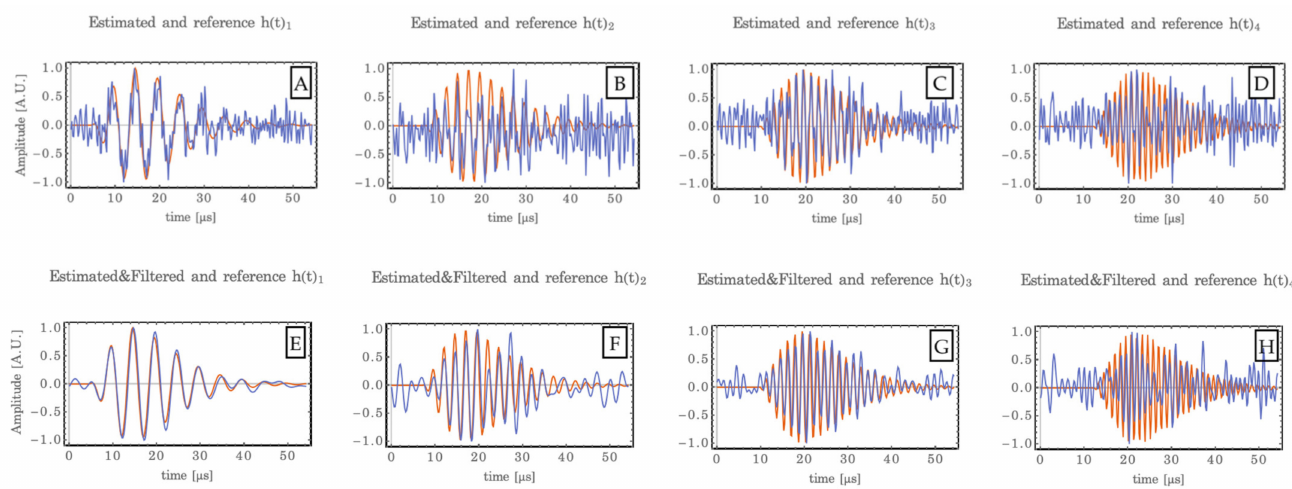
Figure 6. Estimated h k ( t ) kernels in the case SNR 1 = 5 [dB] (blue lines) and reference kernels (red lines). Plots ( A – D ): h 1 ( t ) , h 2 ( t ) , h 3 ( t ) , h 4 ( t ) estimates before lowpass filtering and reference. Plots ( E – H ): h 1 ( t ) , h 2 ( t ) , h 3 ( t ) , h 4 ( t ) estimates after lowpass filtering and reference.